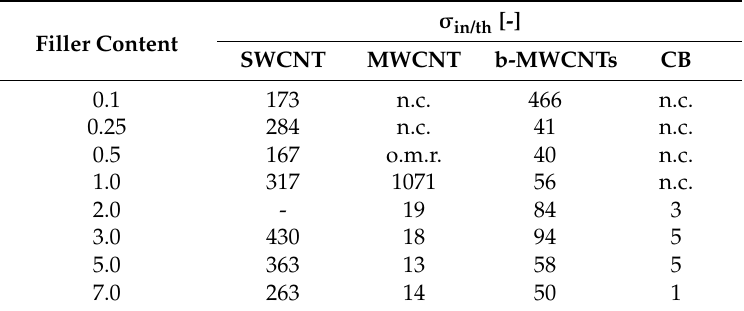
Figure 5. Volume conductivity vs. filler content of PVDF composites with CNTs with different morphology, measured in two directions on compression molded plates. Table 1. Quotient of in-/through-plane σ values ( σ in/th ) of PVDF/carbon fillers composites, compression molded plates.